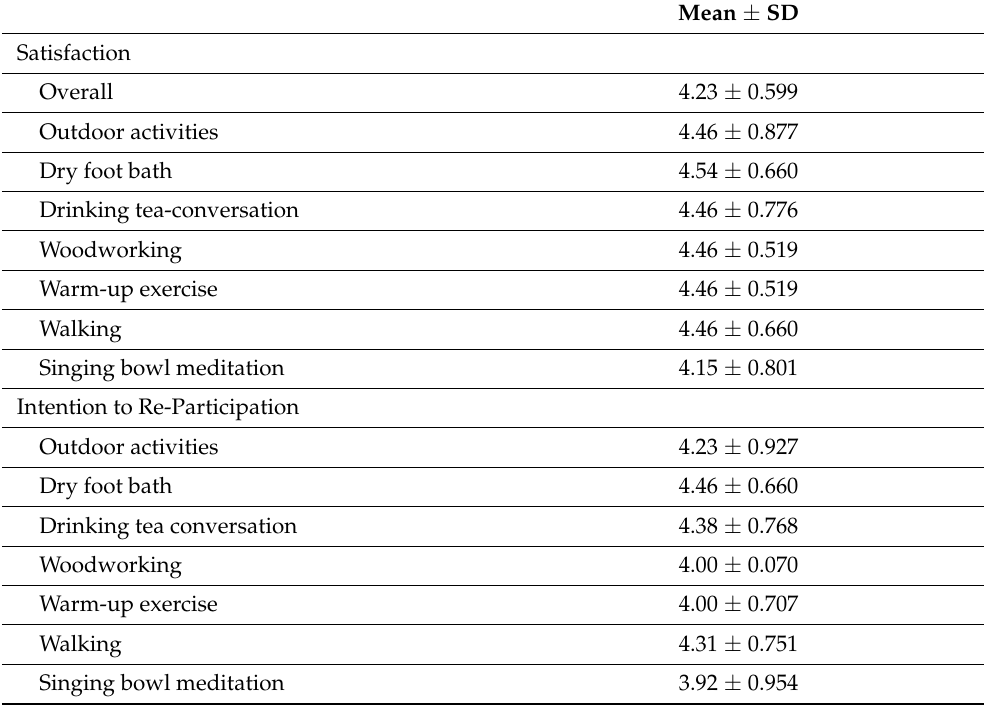
Table 5. The results of satisfaction survey after forest healing